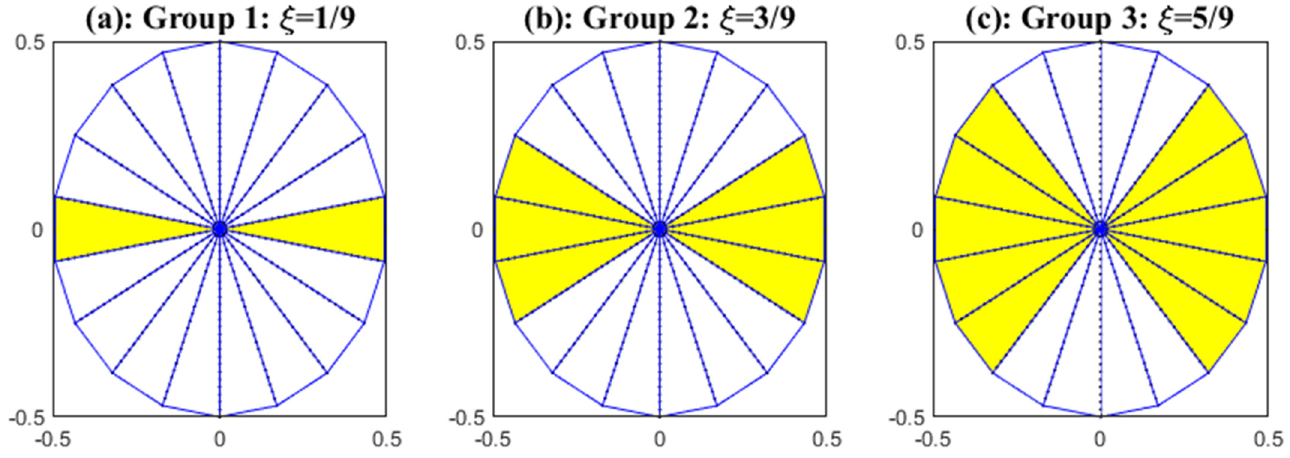
Figure 5. Three kinds of proportion of the yellow areas (the pay zone) corresponding to three groups of crossover experiments. Table 1. The 27 subgroups of values of governing variables 𝜉 and 𝜁 for crossover experiments.